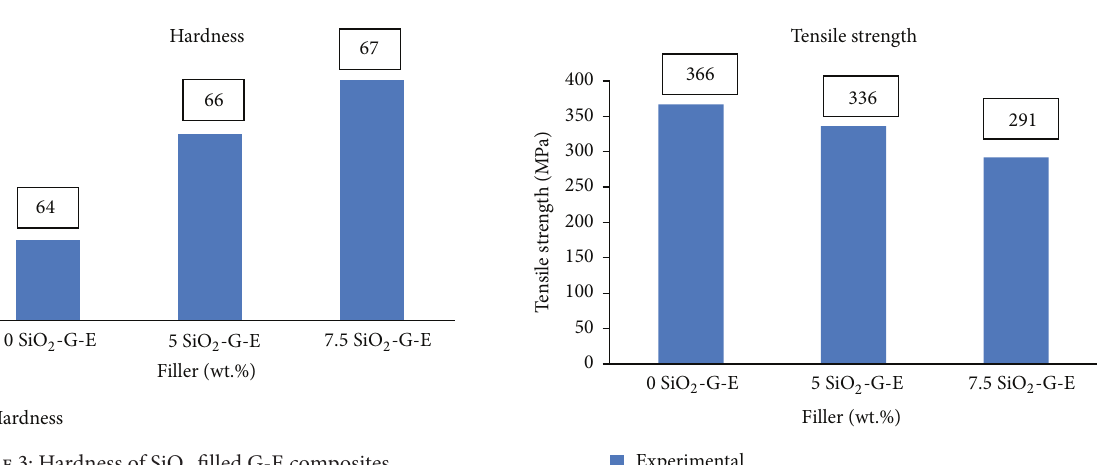
Figure 3: Hardness of SiO 2 filled G-E composites.